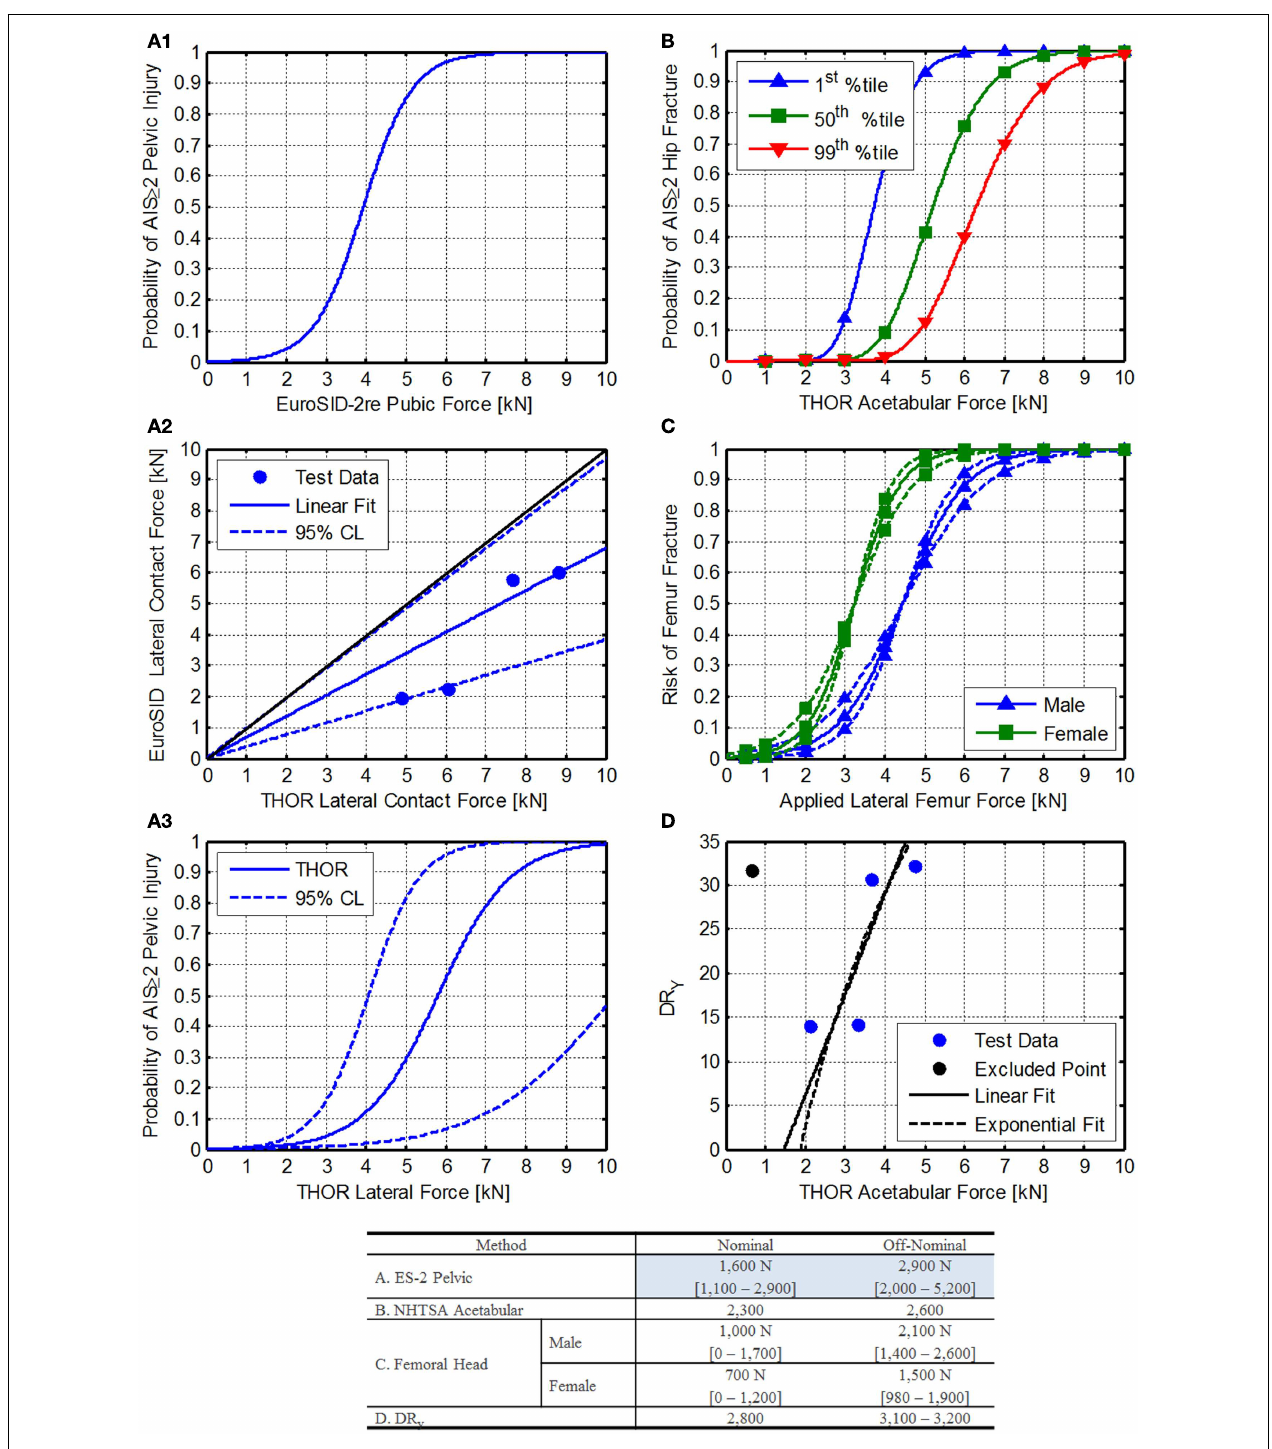
function for lateral contact force, (B) NHTSA acetabular injury risk function for frontal impact as reported by Rupp et al. (2010). (C) Femur fracture risk associated with applied forces in humans.The solid lines are the injury risk estimate, and the dashed lines are the 95% confidence interval. (D) Comparison of theTHOR acetabular loads and the BDRC DR Y .The blue dots are test data, the black line is the linear fit, and the dashed black line is an exponential